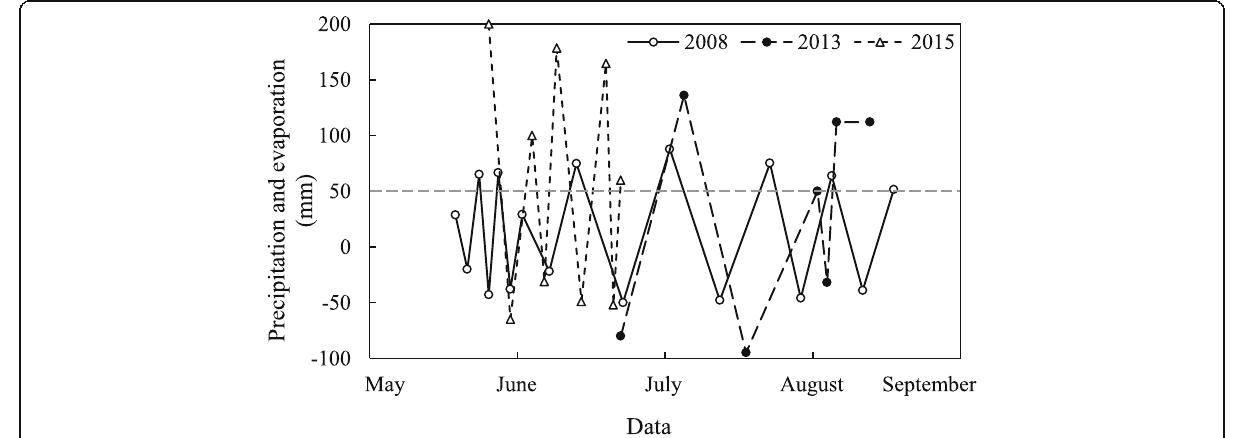
Fig. 3 Precipitation and evaporation in 2008, 2013 and 2015 (after online of Guizhou weather)